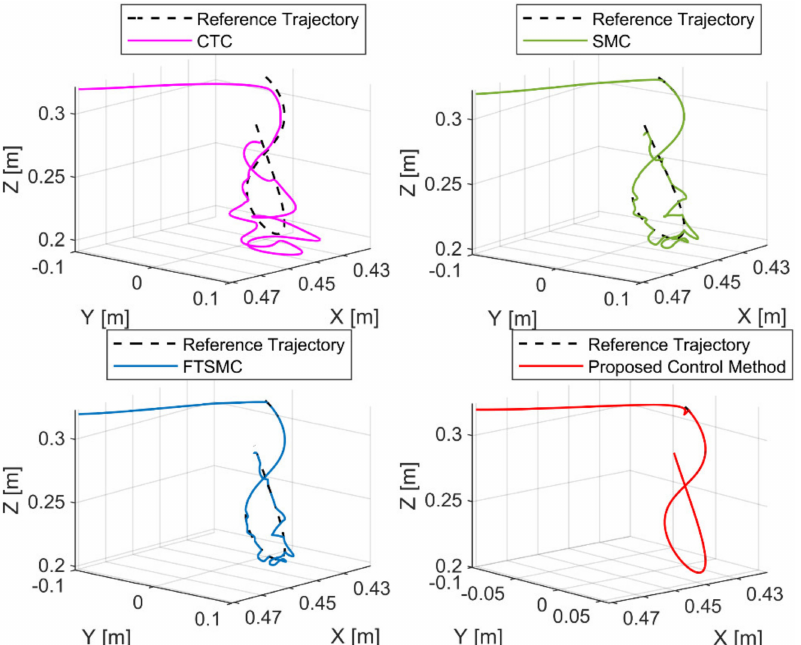
Figure 9. The reference trajectory and real trajectory of the end-effector under four controllers.